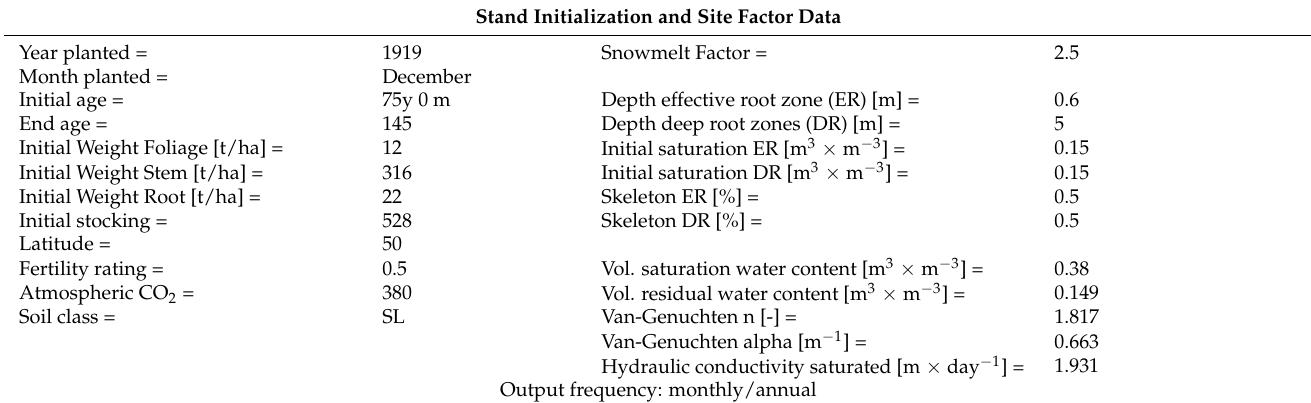
Table A1. Stand Initialization and site factor data.